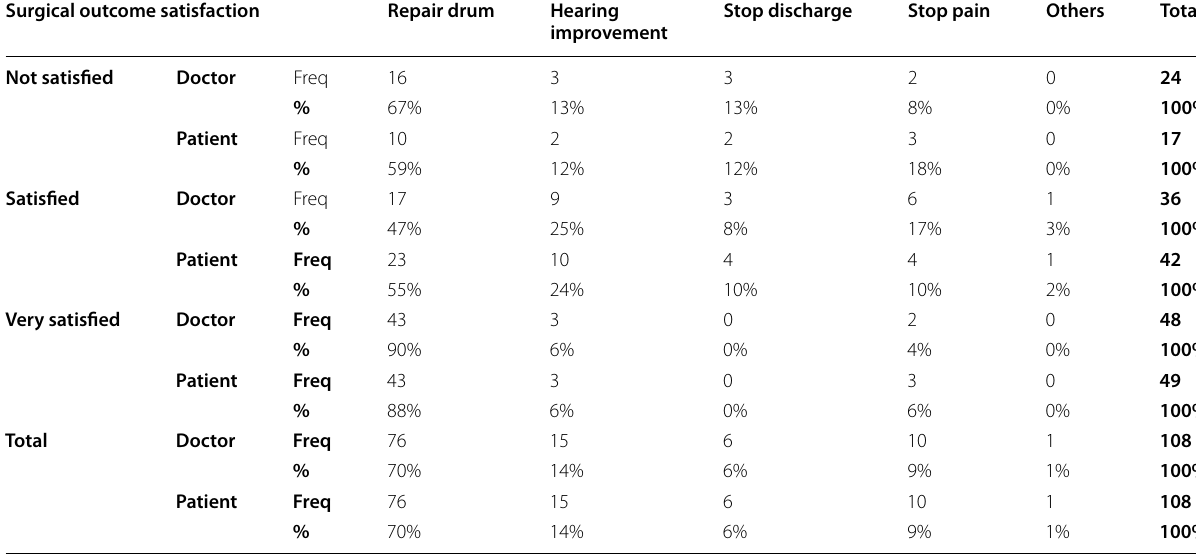
Table 3 Surgical outcome satisfaction score Surgical outcome